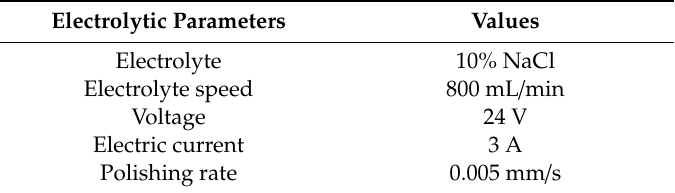
Table 4. Electrolytic corrosion